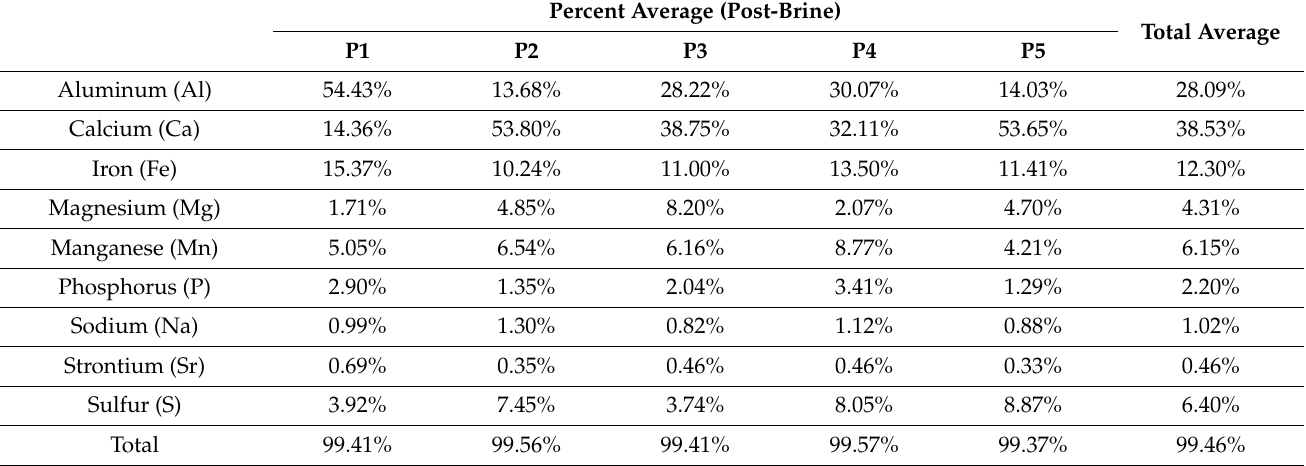
Table 6. Pond sediment metal concentration analysis, initially measured as mg/kg and presented as percent average of two post-brine samples from each pond (P1, P2, P3, P4, P5) and total